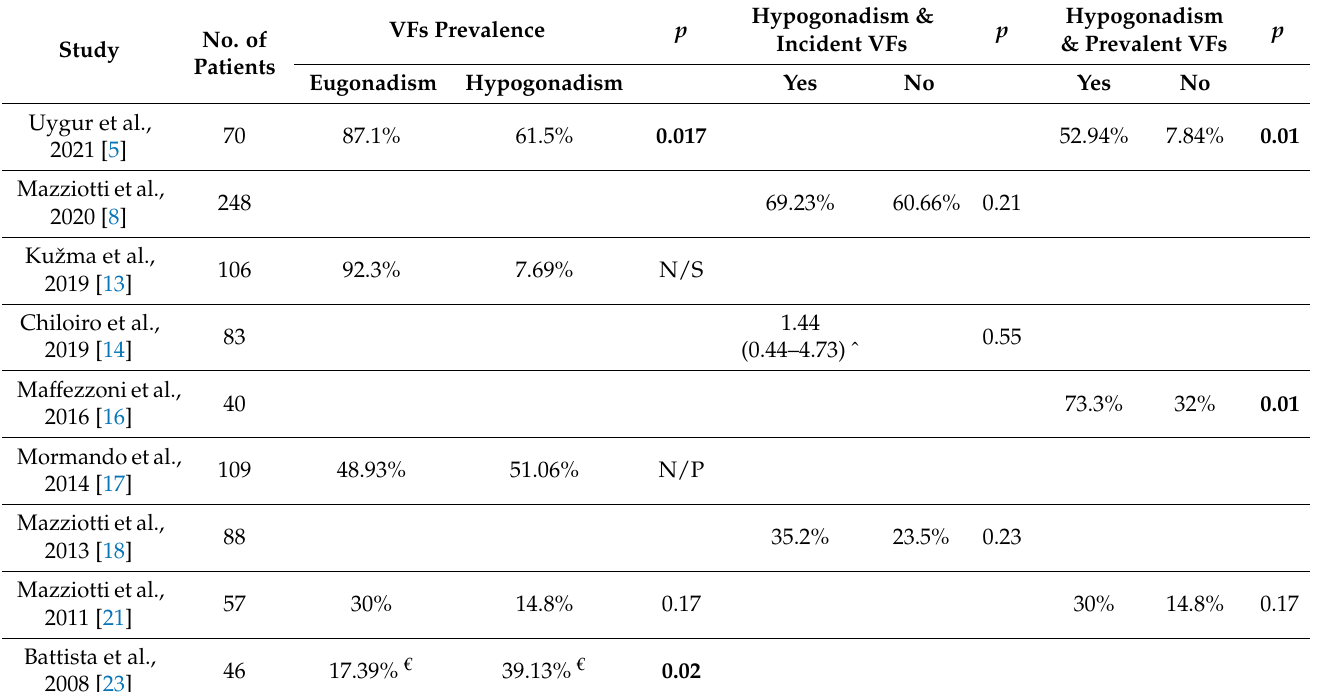
Table 3. Correlations reported between the presence of hypogonadism and vertebral fractures